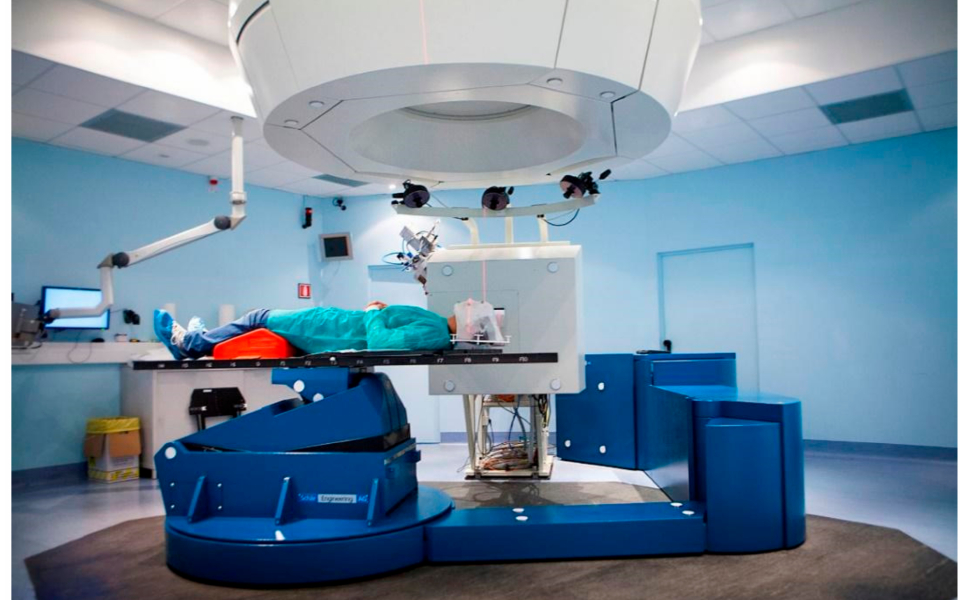
Figure 5. The alignment devices inside the CNAO treatment room. In blue the pantograph robotic couch with 6 degrees of freedom. On the ceiling, the cylinder that incorporates the two orthogonal X-rays tubes and the opposing flat panels. Above the nozzle are also visible three infrared cameras used to monitor on-line the spatial position of refracting markers placed on the patient’s